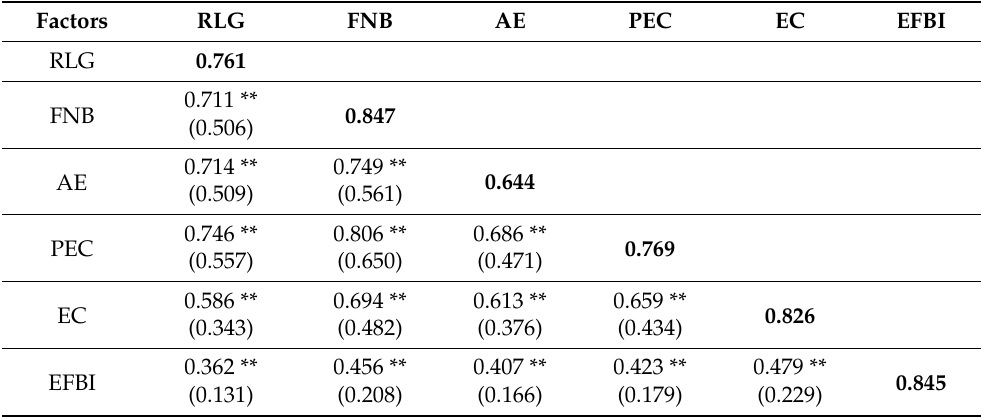
Table 4. Correlation and discriminant validity